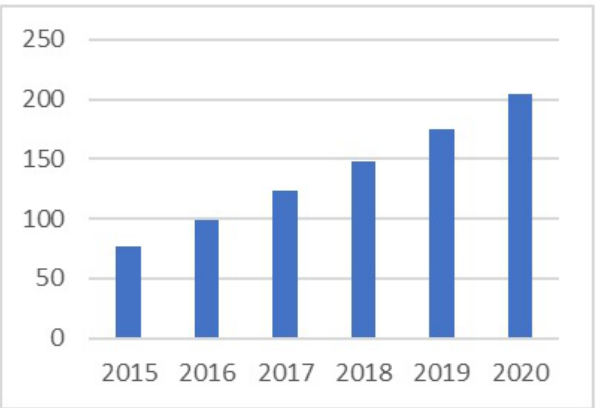
Figure 2. Public IT Cloud Spending